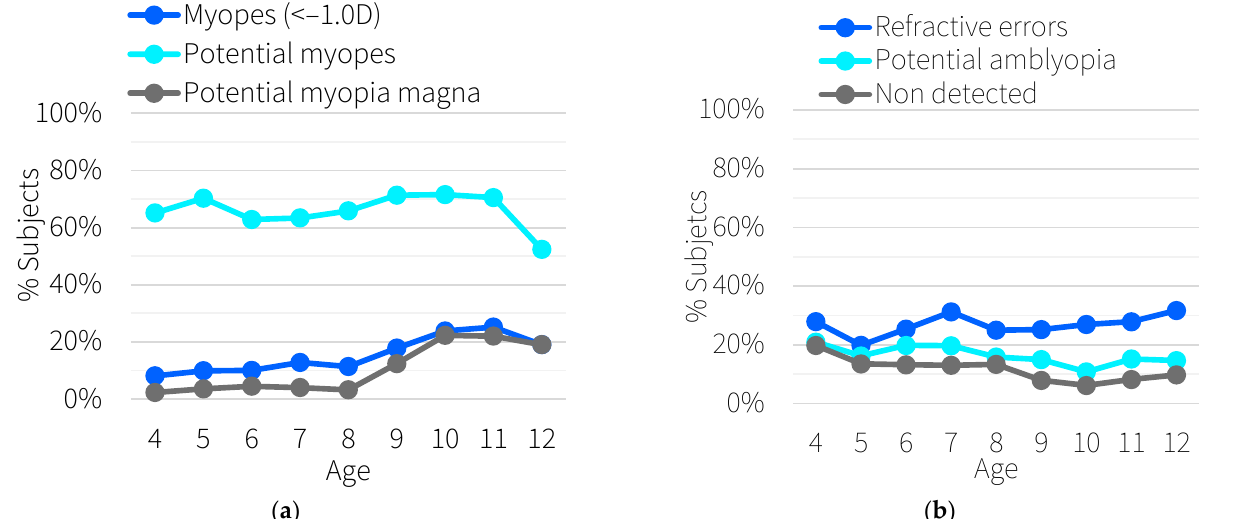
Figure 2. ( a ) Percentage of subjects in the total sample who are myopic (dark blue), at risk of being future myopic (light blue), at risk of having myopia magna (gray). ( b ) Percentage of subjects with potential refractive errors (dark blue), potentially amblyopic (light blue) and uncorrected subjects (gray).